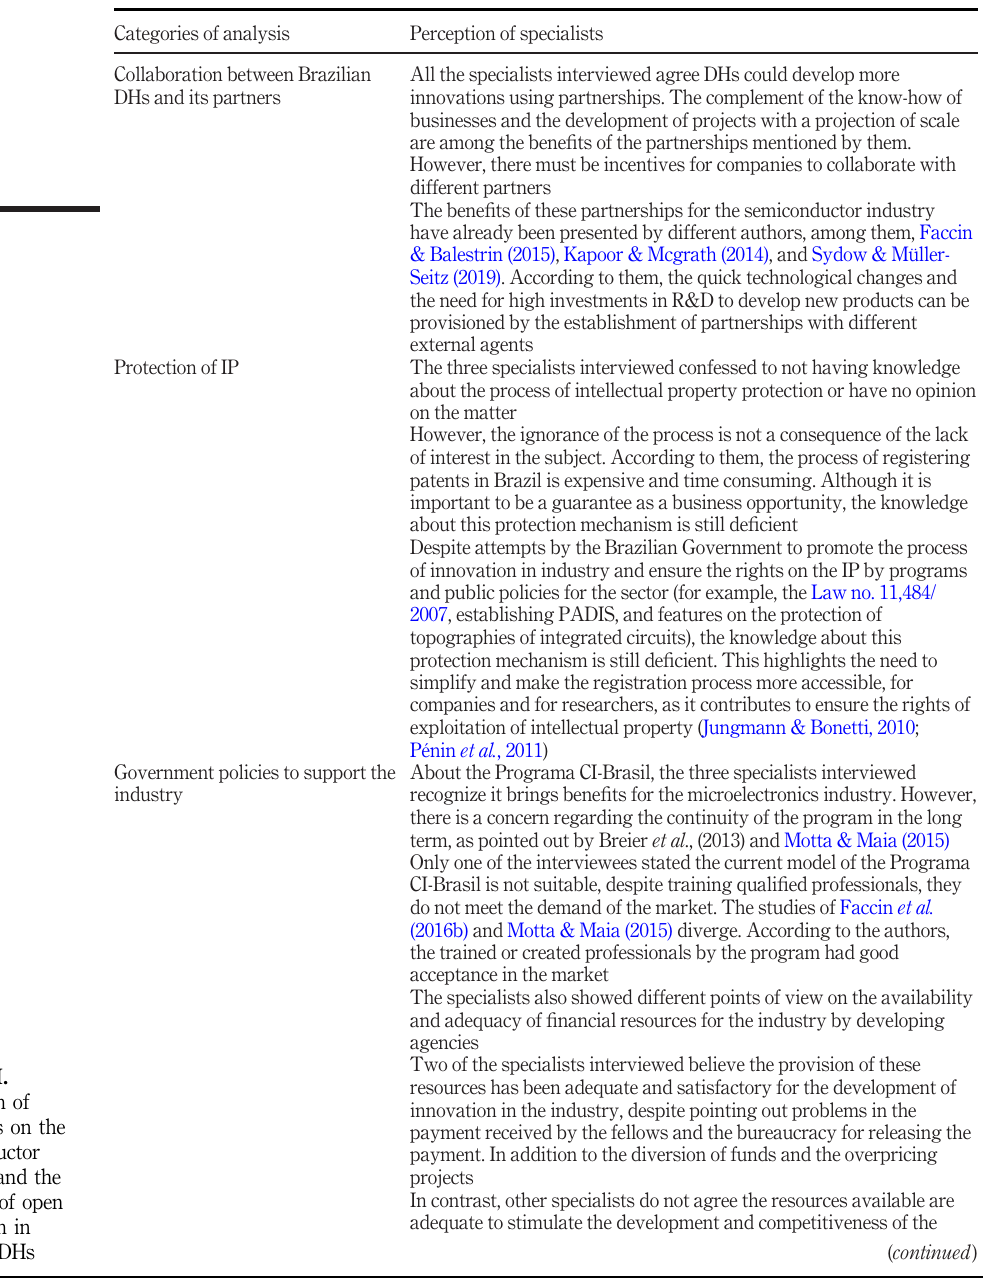
Table VI. Perception of specialists on the semiconductor industry and